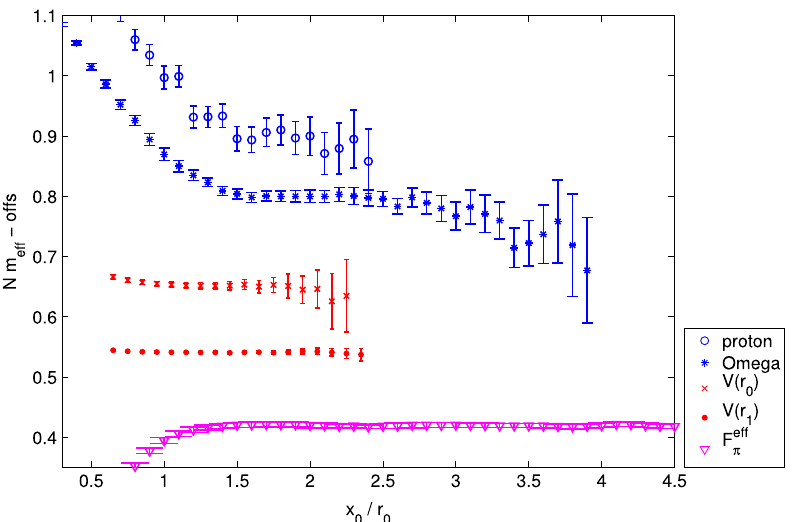
Fig. 50 Effective masses for M proton [1034], M (cid:12) [1035], V ( ≈ r 0 ) , V ( ≈ r 1 ) [707] and f π [314] on N f = 2 CLS ensemble N6 with a = 0 . 045fm , M π = 340 MeV on a 48 3 96 lattice [314]. All effective “masses” have been scaled such that the errors in the graph reflect directly the errors of the determined scales. They are shifted vertically by arbitrary amounts. Figure from Ref. [714]. Note that this example is at still favourably large quark masses. The situation for M proton becomes worse closer to the physical point, but may be changed by algorithmic